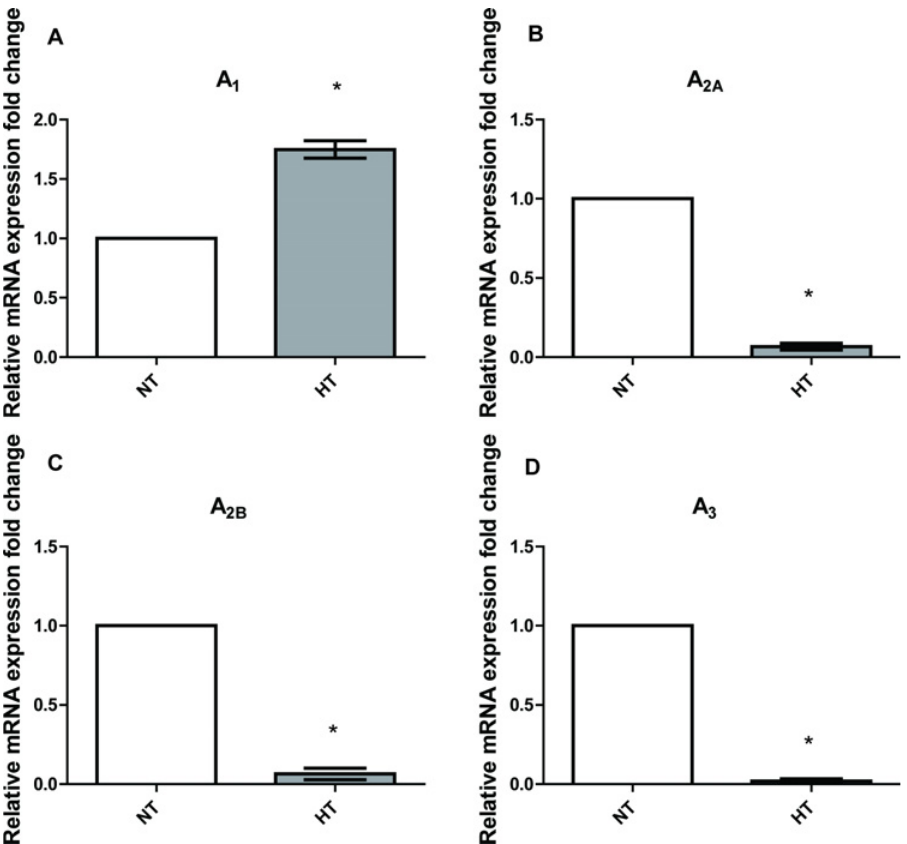
Fig 5. The relative expression of adenosine receptor subtype mRNA in left ventricle. A Student ’ s t test was performed as compared spontaneously hypertensive rat group (HT) with normotensive group (NT), (n = 8 for each group), * A p value (cid:1) 0.05 was considered statistically